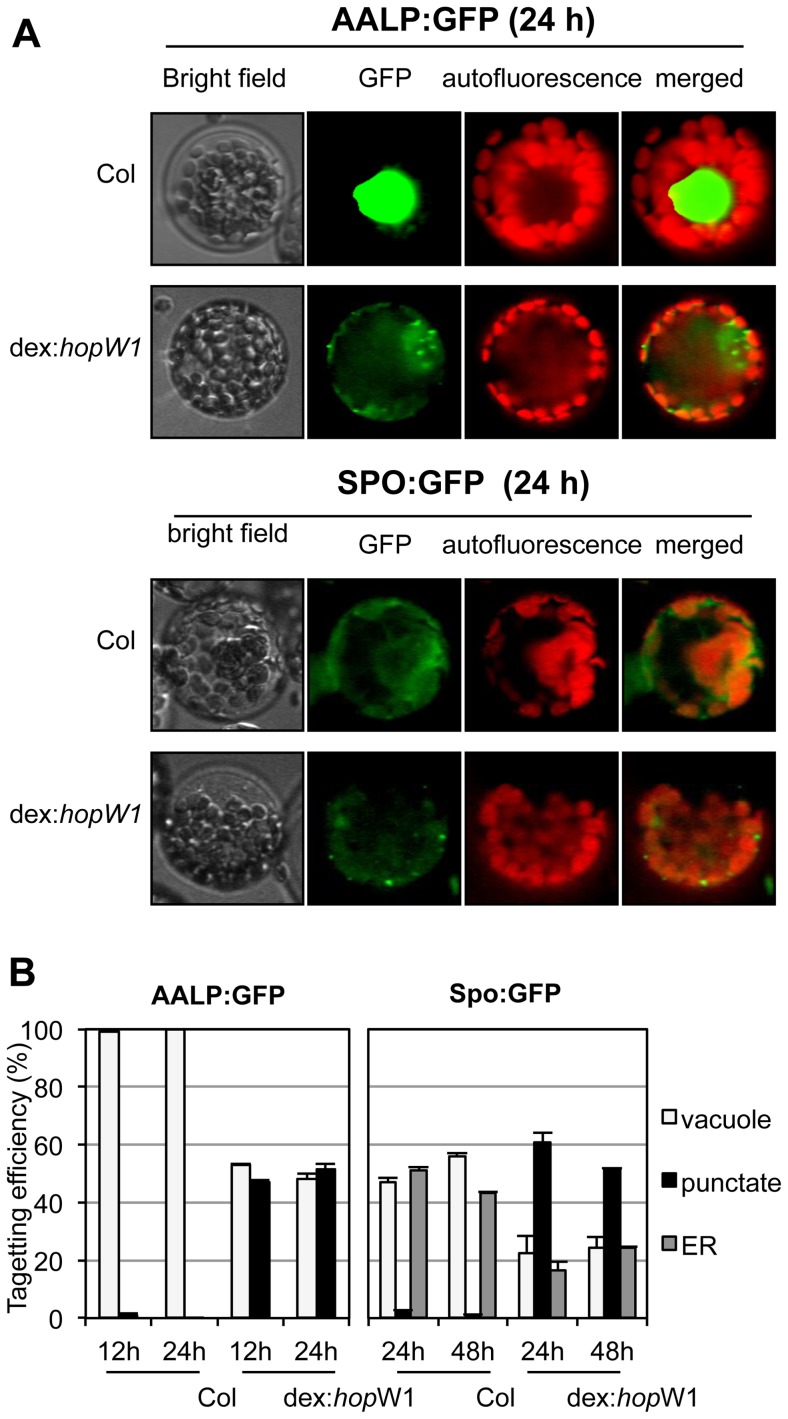
Inhibition of the vacuolar and ER trafficking by HopW1.(A) Wild-type and dex:hopW1 Arabidopsis Col protoplasts were transfected with AALP:GFP or SPO:GFP and incubated with 0.2 µM dex for the indicated times and imaged using fluorescence microscopy. AALP:GFP was targeted to the central vacuole and SPO:GFP localized to the ER and vacuole in wild-type protoplasts, as previously documented [14]; upper rows in each panel show examples of vacuole and ER localization, respectively. However, in the presence of HopW1, many protoplasts transfected with the AALP:GFP and SPO:GFP showed notable punctate patterns. (B) Localization patterns were quantified from at least 100 images, such as those in (A); see also Figure S2A for comparison with the effect of LatB. Bars indicate SEM. χ
2 tests indicated that the distributions were significantly different between the wild-type and dex:hopW1 at each time point (P<0.0001, n≥100 per genotype/fusion construct). This experiment was performed three times using at least two transgenic dex:HopW1 lines, with similar results.